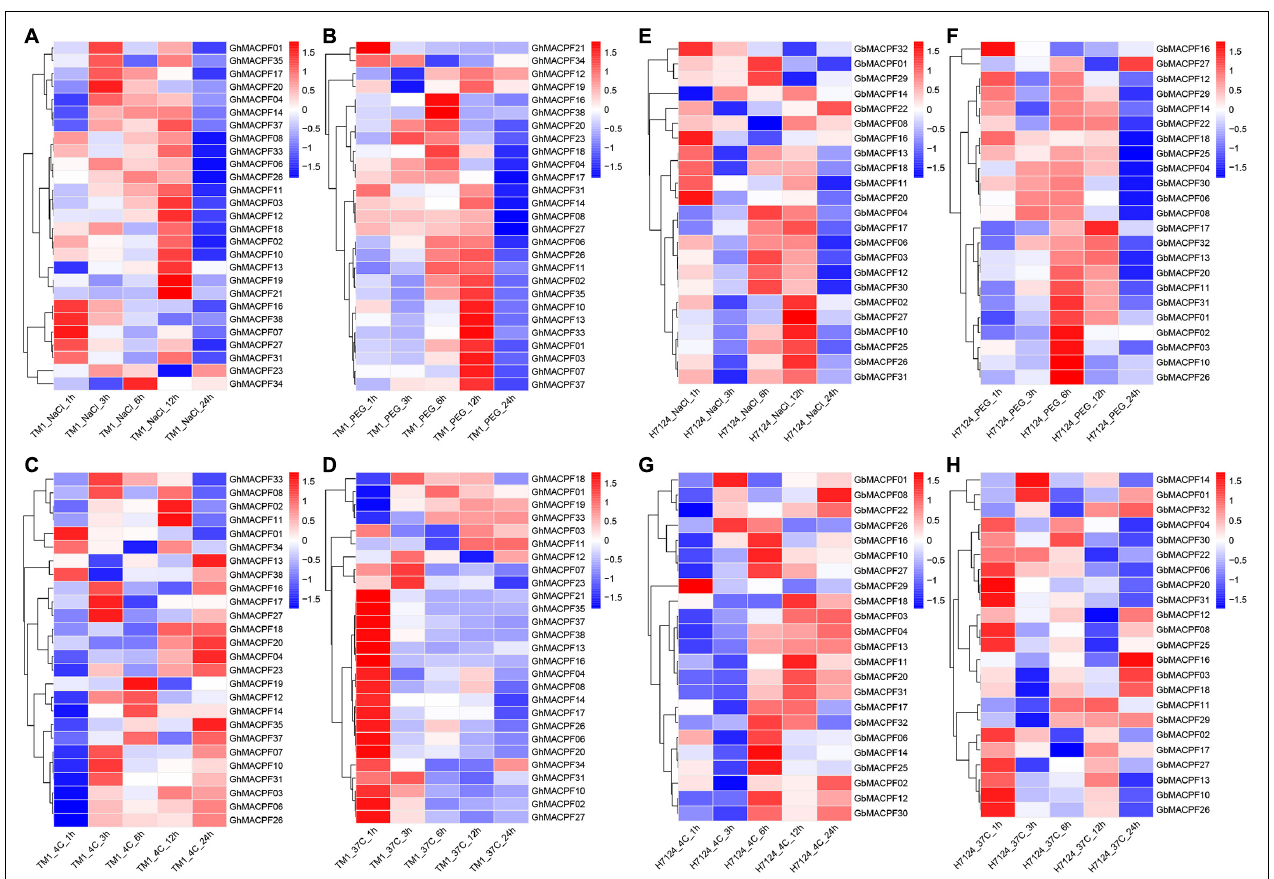
FIGURE 4 | Expression profiles of the MACPF member in response to the different abiotic stresses. The expression levels of GhMACPFs and GbMACPFs under salt stresses (A,E) , polyethylene glycol (PEG) stresses (B,F) , cold stresses (C,G) , and hot stresses (D,H) , respectively.